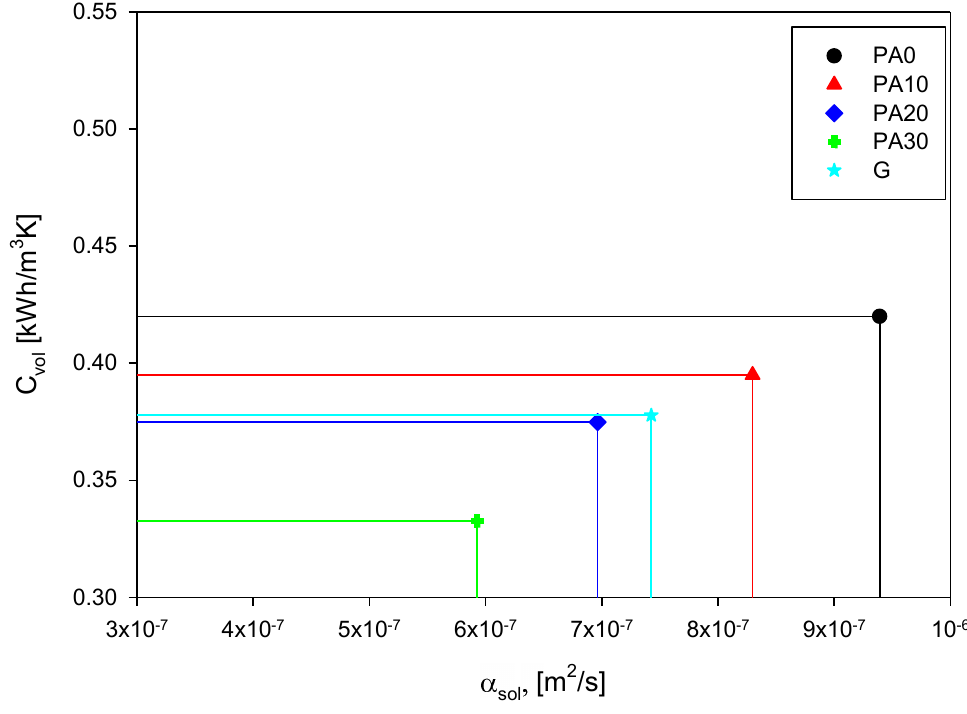
Figure 11. Thermal properties of the developed storage